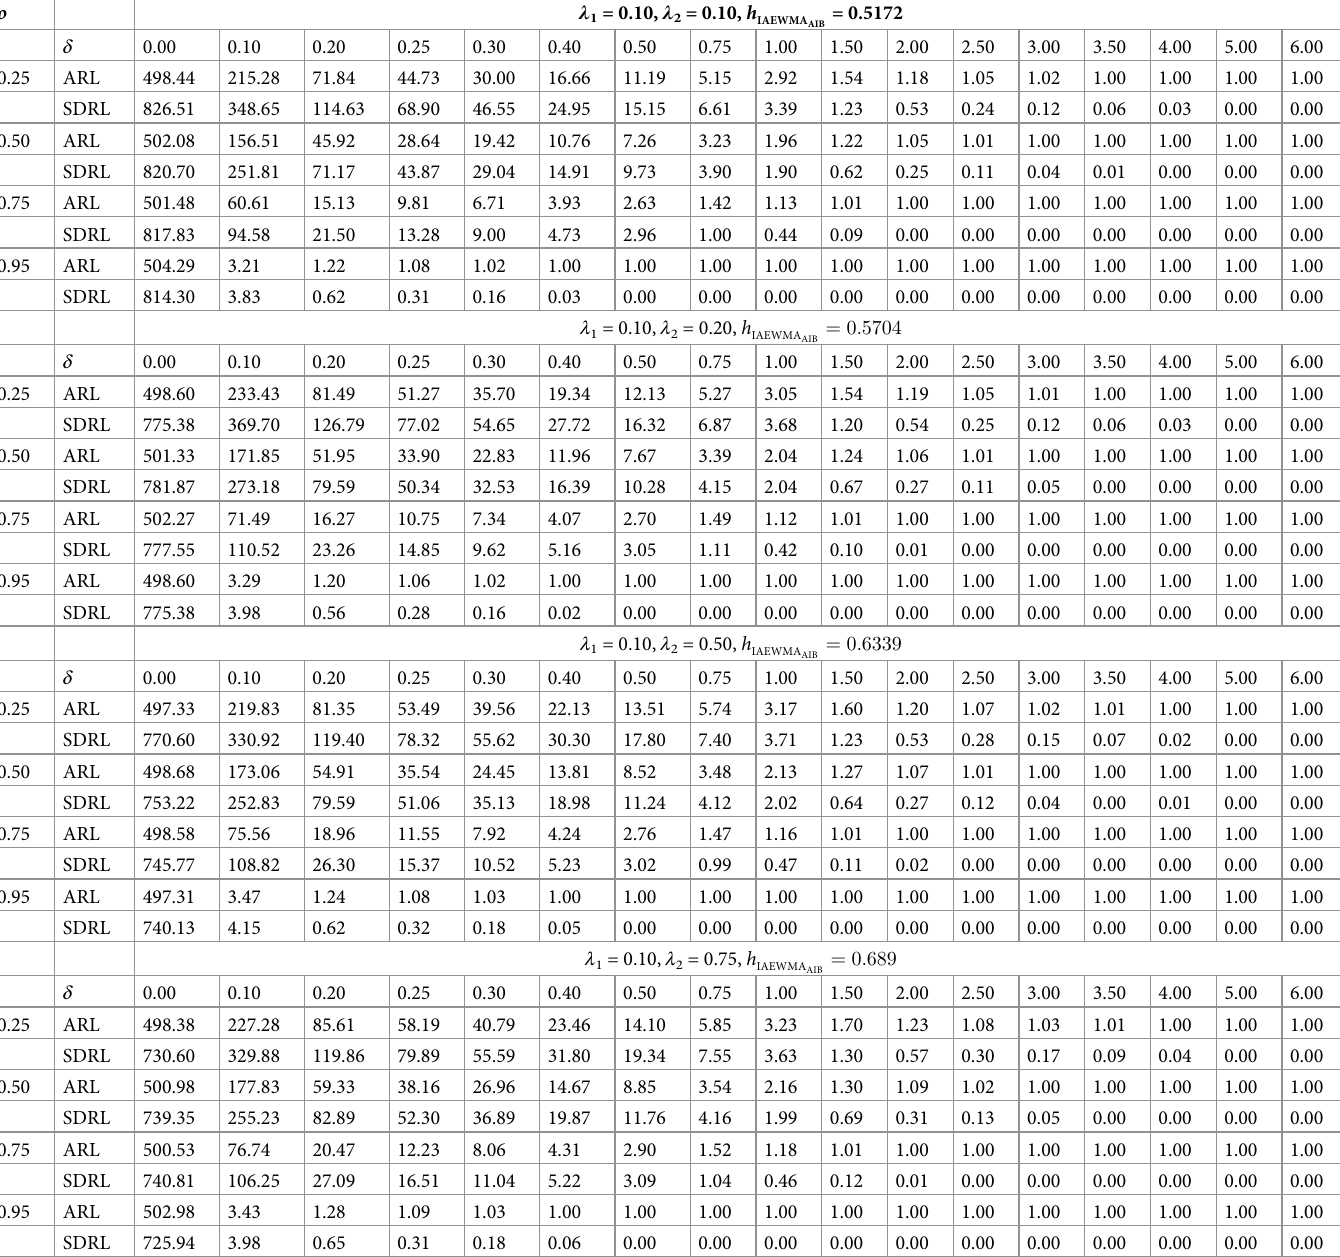
Table 1. The run-length profile of proposed IAEWMA AIB control chart under various choices of λ 2 when λ 1 is small and ARL 0 = 500.